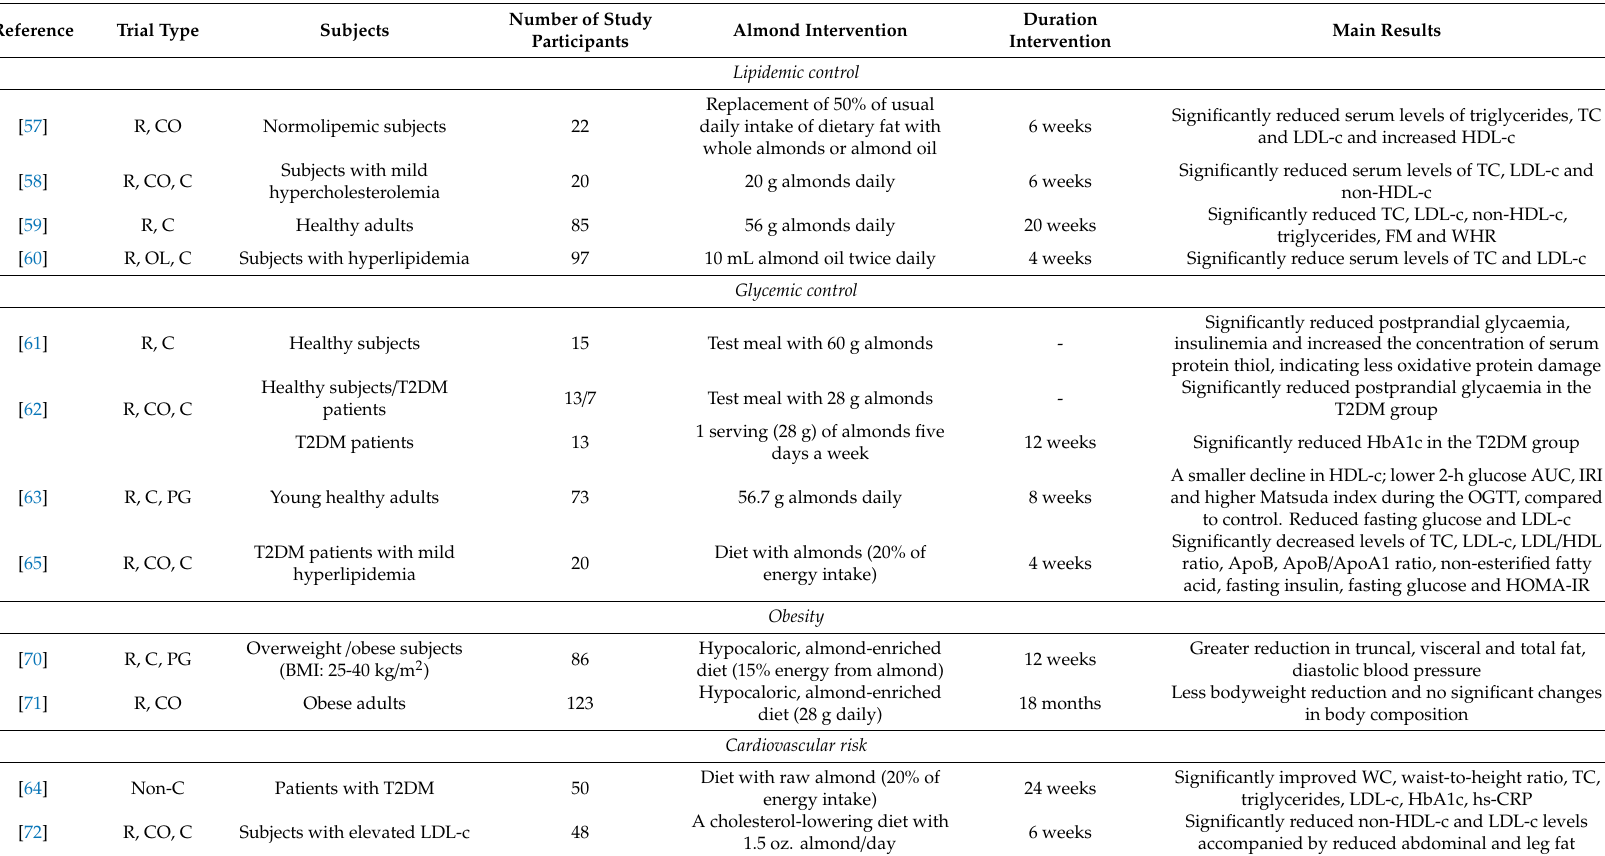
Table 6. Clinical trials investigating the health-promoting properties of